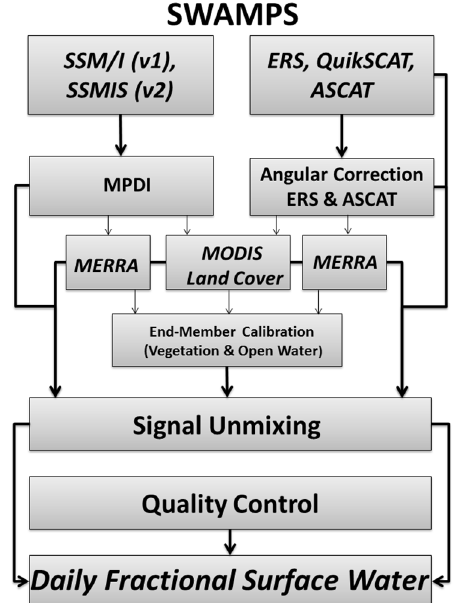
Figure 1. Flow chart of the Surface WAter Microwave Product Series (SWAMPS) surface water fraction retrieval scheme including the calibration of vegetation and open water end-members and post-product quality control.